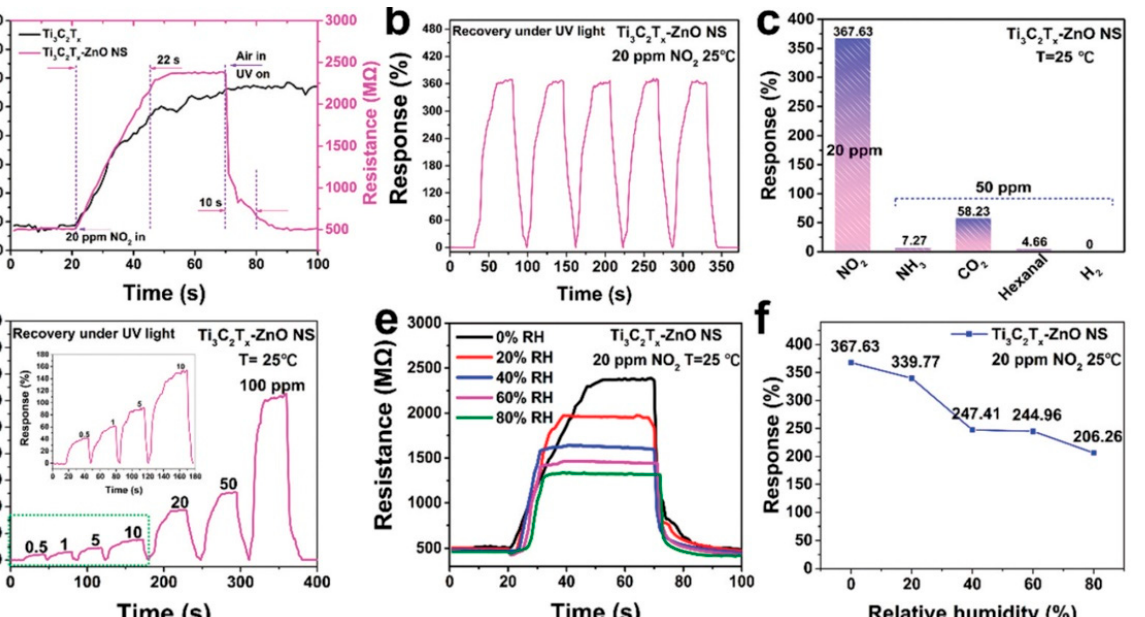
Figure 21. ( a ) Schematic diagram of the possible gas-sensing mechanism of Ti 3 C 2 T x /ZnO NS. ( b ) Energy band structure diagram of Ti 3 C 2 T x /ZnO NS Schottky barriers in air and NO 2 . Reprinted with permission from [123]. Copyright 2022: The Royal Society of Chemistry. DFT calculations indicate that the main adsorption centers belong to ZnO nanosheets, while Ti 3 C 2 T x acts as a conductive channel to accelerate charge transfer [123]. A more complex multistep synthesis was employed to obtain a mesoporous Ti 3 C 2 T x /ZnO composite as part of an efficient NO 2 optoelectronic sensor [124], where ZnO nanorods were grown on the surface of MXene from seed ZnO nanoparticles. The oxide